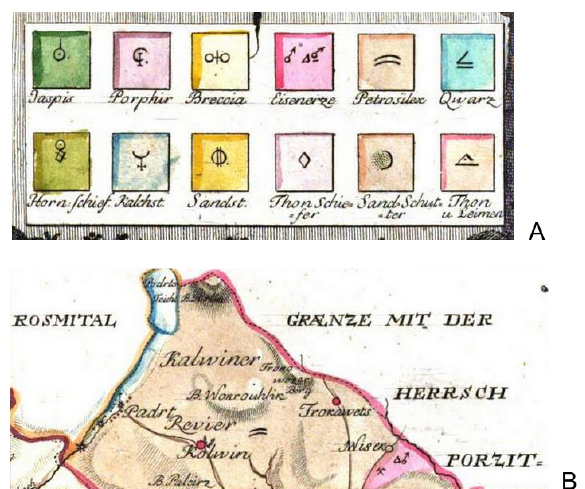
Fig. 8. A – the legend placed in the right upper corner of the map Petrographische Karte derer Kammeral­Herrschaften Zbirow… by J. Jirasek, B – a part of the map where on the upper left – side limestone rocks were marked and in the lower left corner – iron ore and the mine, and in the center on a larger area – flints Petrosilae (the collection of the Narodni knihovna ČR in